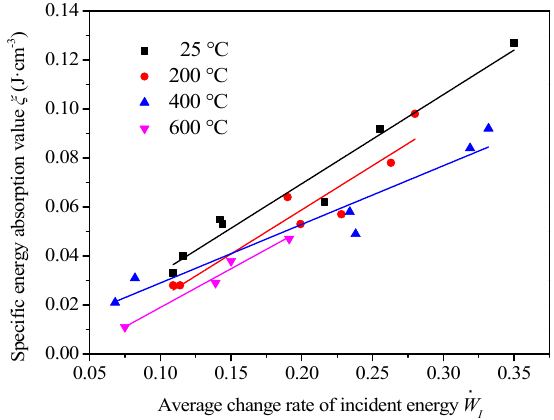
Figure 15. The specific energy absorption vs. the average change rate of incident energy.